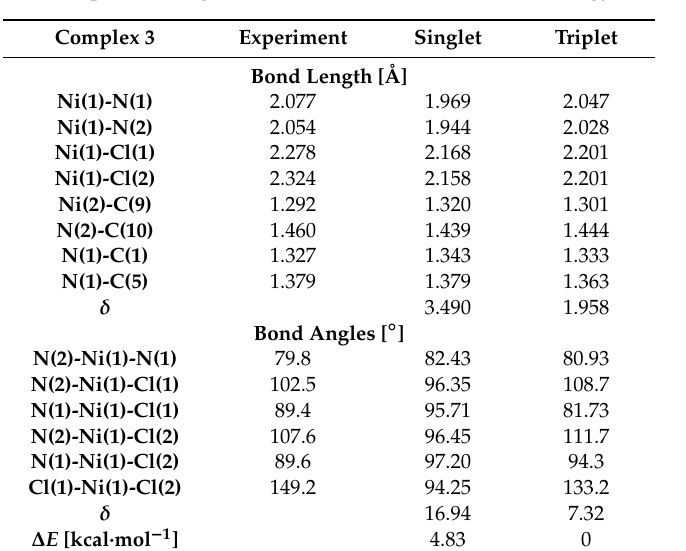
Table 2. The comparisons of bond lengths and bond angles between calculated geometry and experimental data for complex 3 along with standard deviations ( δ ) and energy variations ( ∆ E ).